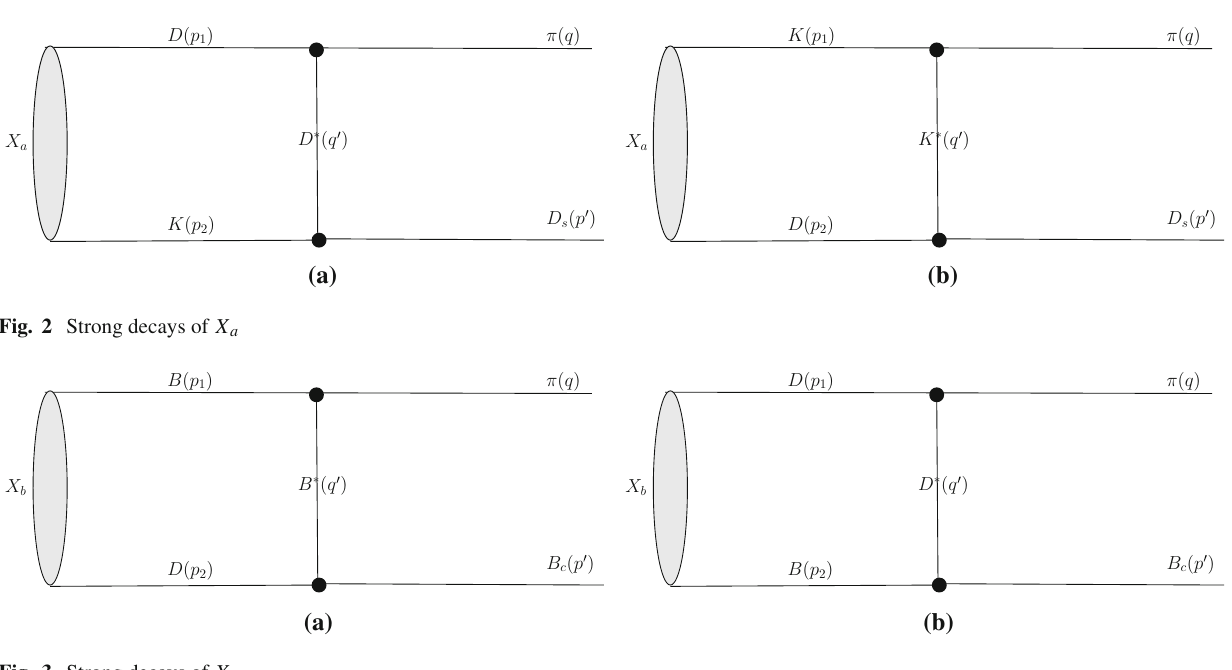
Fig. 2 Strong decays of X a